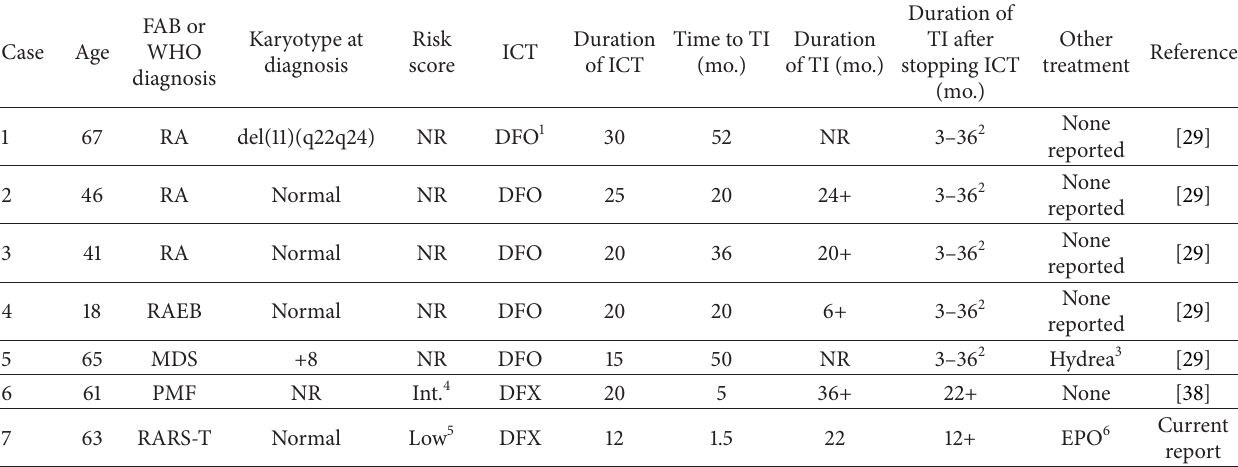
Table 1: Characteristics of patients reported to have achieved sustained transfusion independence after stopping iron chelation therapy.